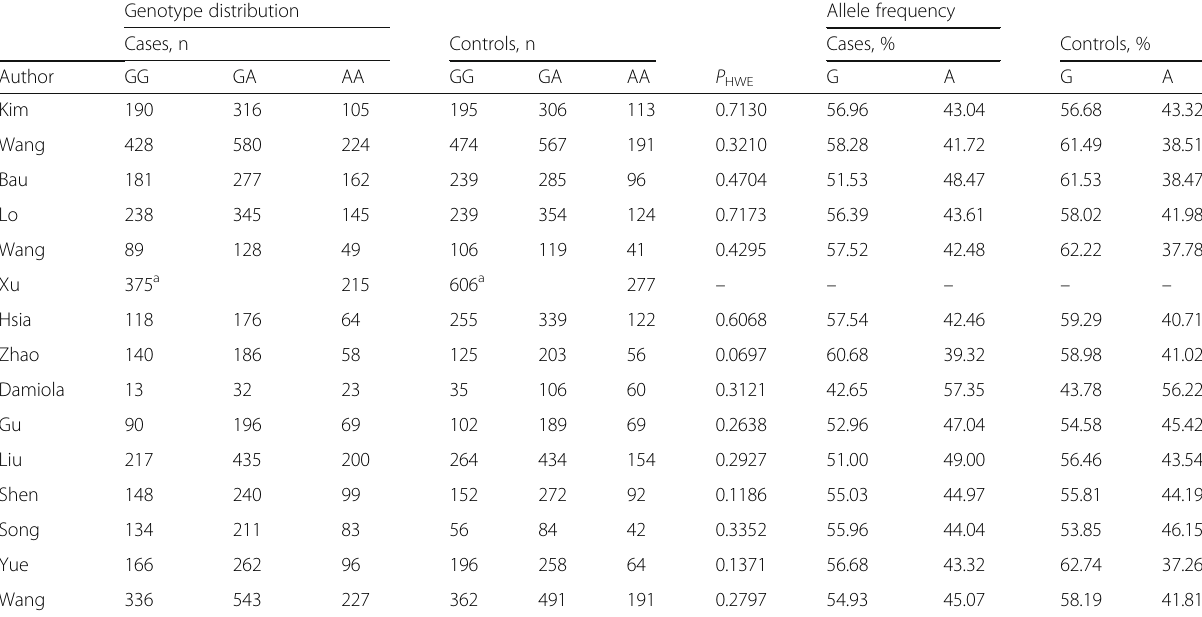
Table 2 Distribution of genotype and allele frequencies of the ATM rs189037 polymorphism Genotype distribution Allele frequency